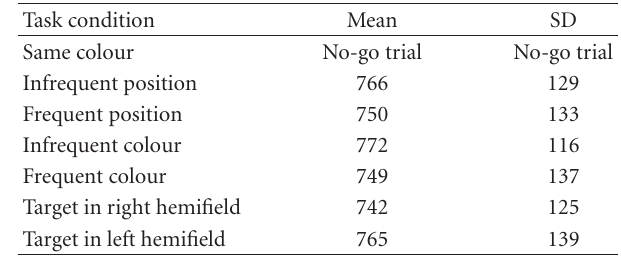
Table 1: Accuracy (percent) for each task condition. Table 2: Reaction time (ms) for each task condition, for correct answers.